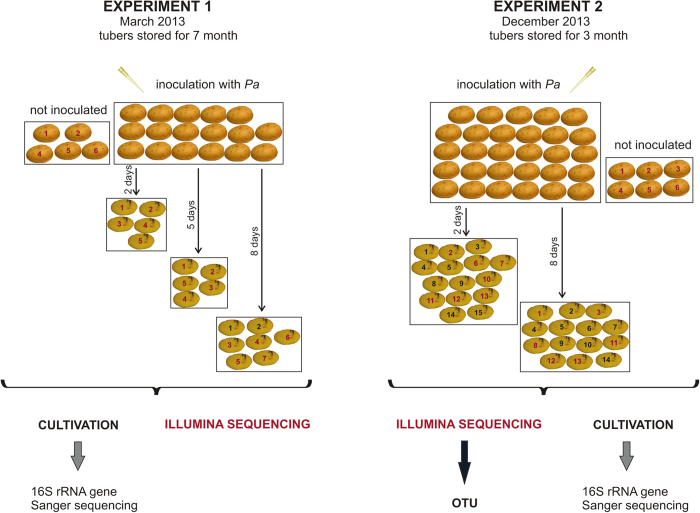
Schematic representation of the experimental setup.Bacteria were cultivated from all the potatoes marked with numbers. Red numbers indicate that the Illumina sequencing was performed in addition to the cultivation. Pa designates inoculation with the pathogen, P. atrosepticum.